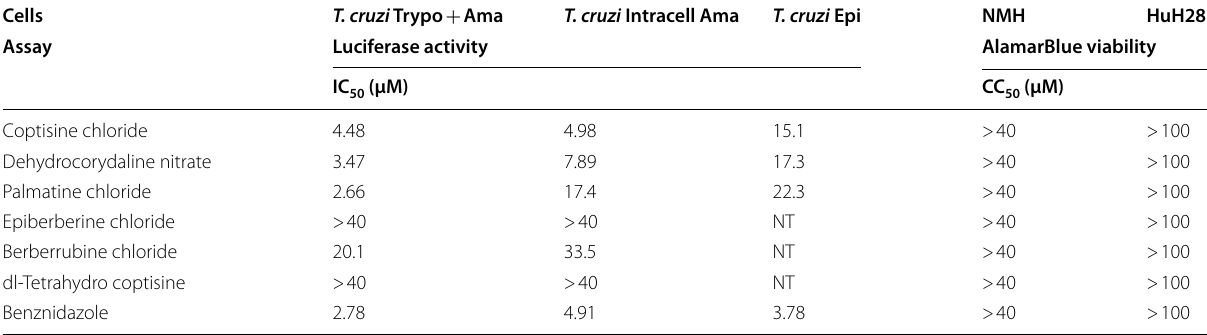
Table 1 IC , and CC , of different compounds on T. cruzi (Trypo: trypomastigote, Ama: amastigote, Epi: epimastigote) and 50 50 mammalian cell (NMH, HuH28) lines